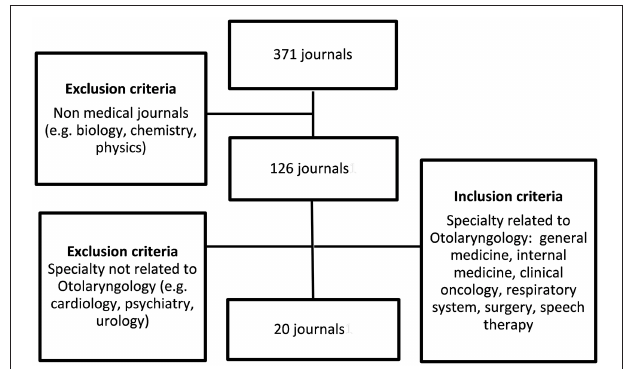
FIGURE 1 | Selection of